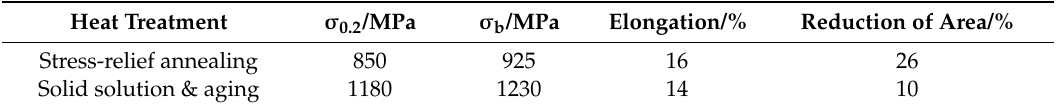
Table 2. The mechanical properties of Ti6Al4V